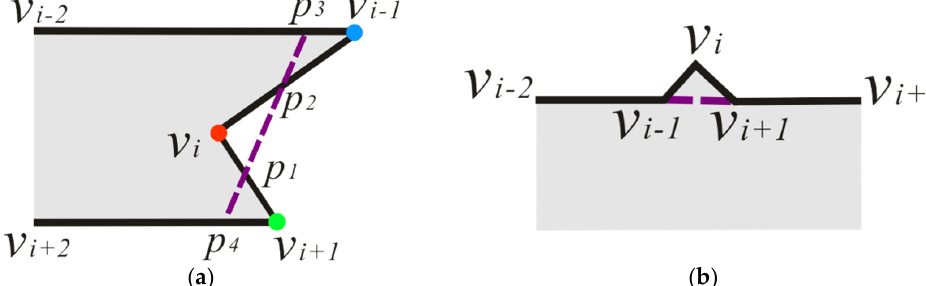
Figure 8. The simplification subtype 9 and its operations: ( a ) Subtype 9 , and ( b ) is the case that v i − 2 v i − 1 and v i + 1 v i + 2 are